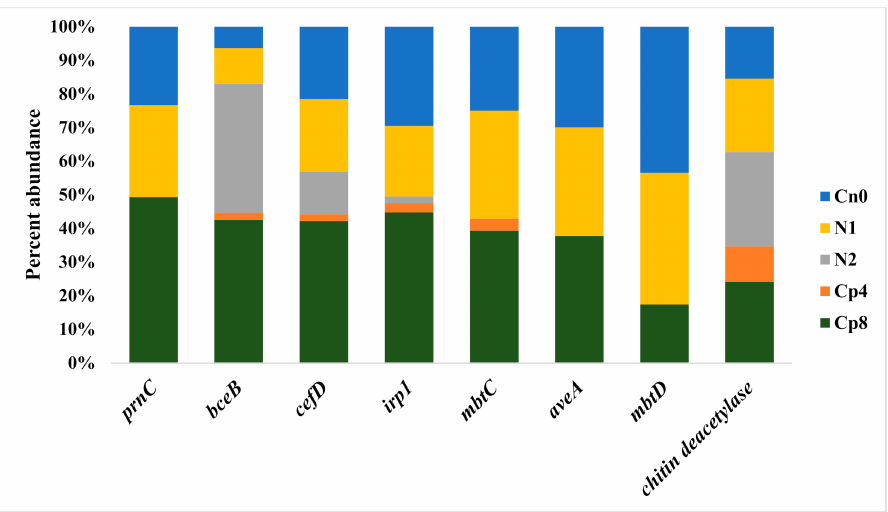
Figure 3. The percentage distribution of antimicrobial and siderophores producing genes within the rhi- zosphere soil of maize treated with organic, inorganic fertilizers and control treatments Cn0 (control), Cp8 (8 tons/ha compost manure), Cp4 (4 tons/ha compost manure), N2 (120 kg/ha inorganic fertilizer) and N1 (60 kg/ha inorganic fertilizer). prnC (FADH2 O2-dependent halogenase II), bceB (bacitracin transport system permease protein), cefD (isopenicillin-N epimerase), irp1 (yersiniabactin nonribo- somal peptide/polyketides), mbtC (mycobactin polyketide synthase MbtC), aveA (type 1 polyketide synthase AVES), mbtD (mycobactin polyketide synthase MbtD).